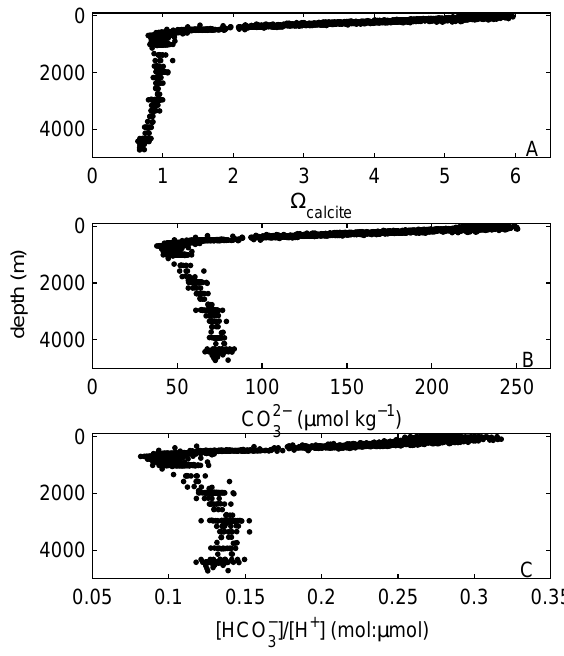
Figure 7. Change in (a) (cid:127) CaCO (c) [HCO − ] / [H + ] on a depth gradient at ALOHA time-series 3 station near Hawaii (22 ◦ 45 (cid:48) N 158 ◦ 00 (cid:48) W). Compiled data from 1988–2012 which was downloaded from the ALOHA